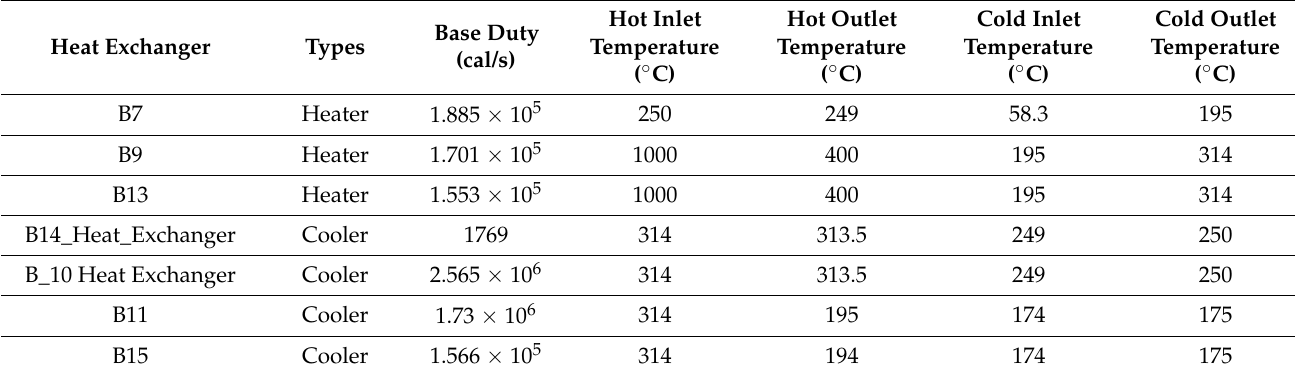
Table 3. Pinch Analysis temperature interval result by using Aspen Plus.